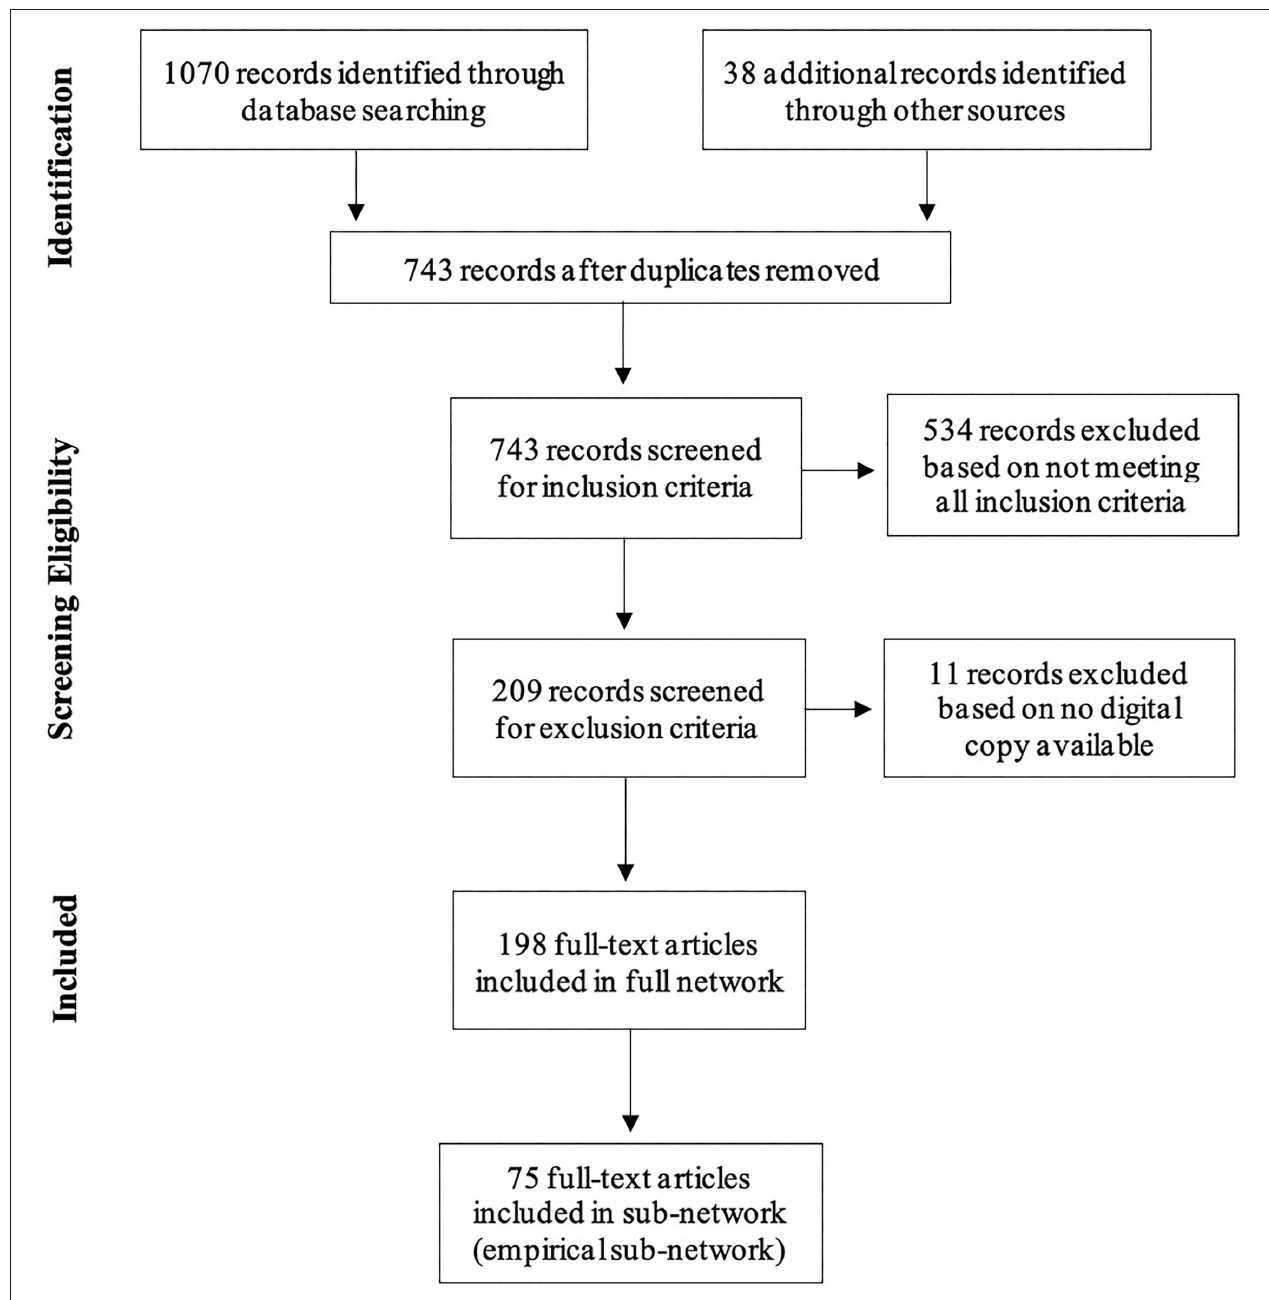
FIGURE 1 | Preferred Reporting Items for Systematic Reviews and Meta-Analyses flow diagram.